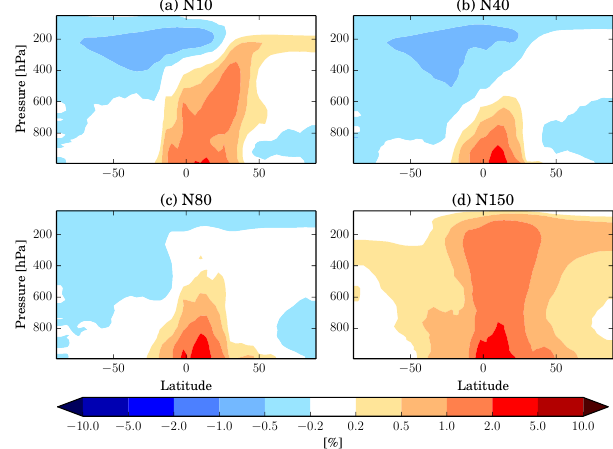
Figure 5. The annually and zonally averaged percent change throughout the troposphere for (a) N10, (b) N40, (c) N80, and (d) N150 for the BASE–NOBIOF comparison.